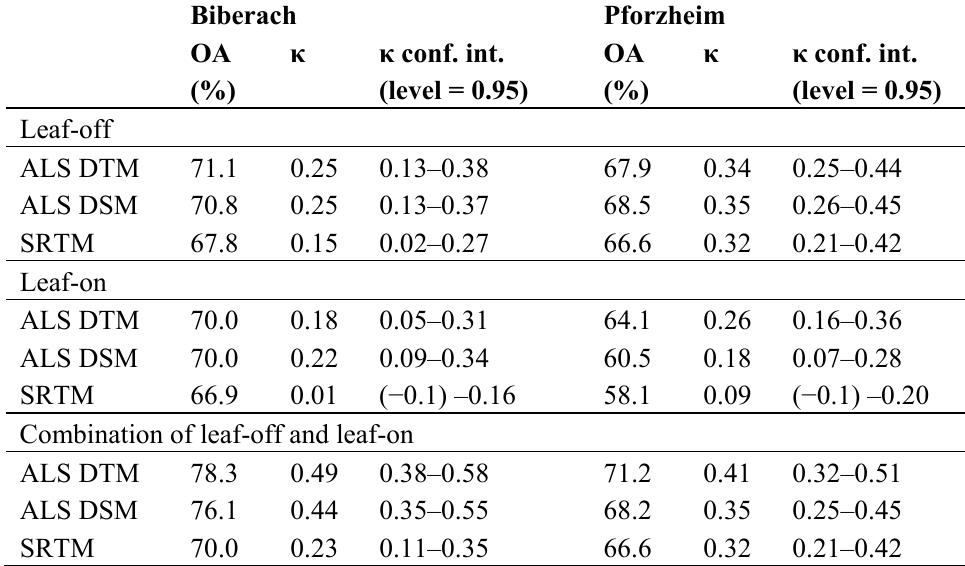
Table 3. Classification accuracy of deciduous- and coniferous-dominated sample plots using leaf-off and leaf-on SAR images ( σ 0 ).